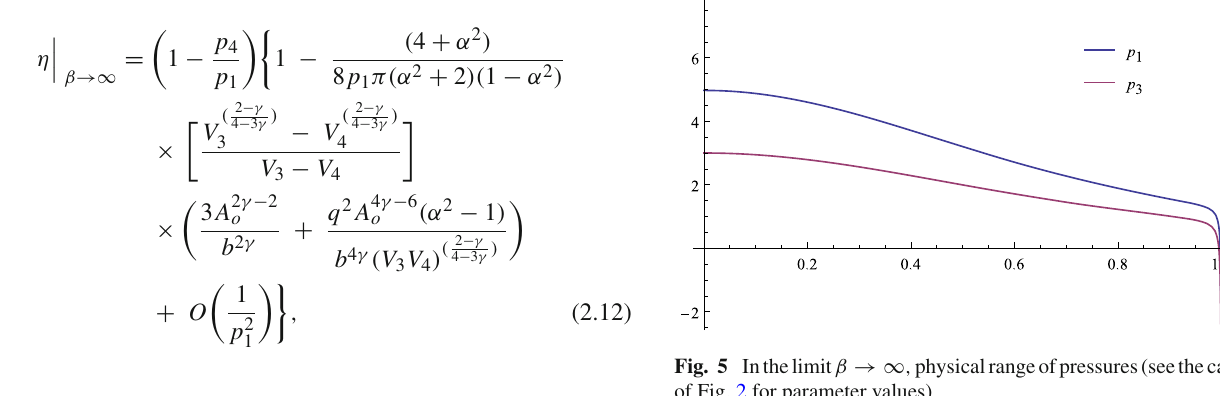
For large p 1 , one obtains